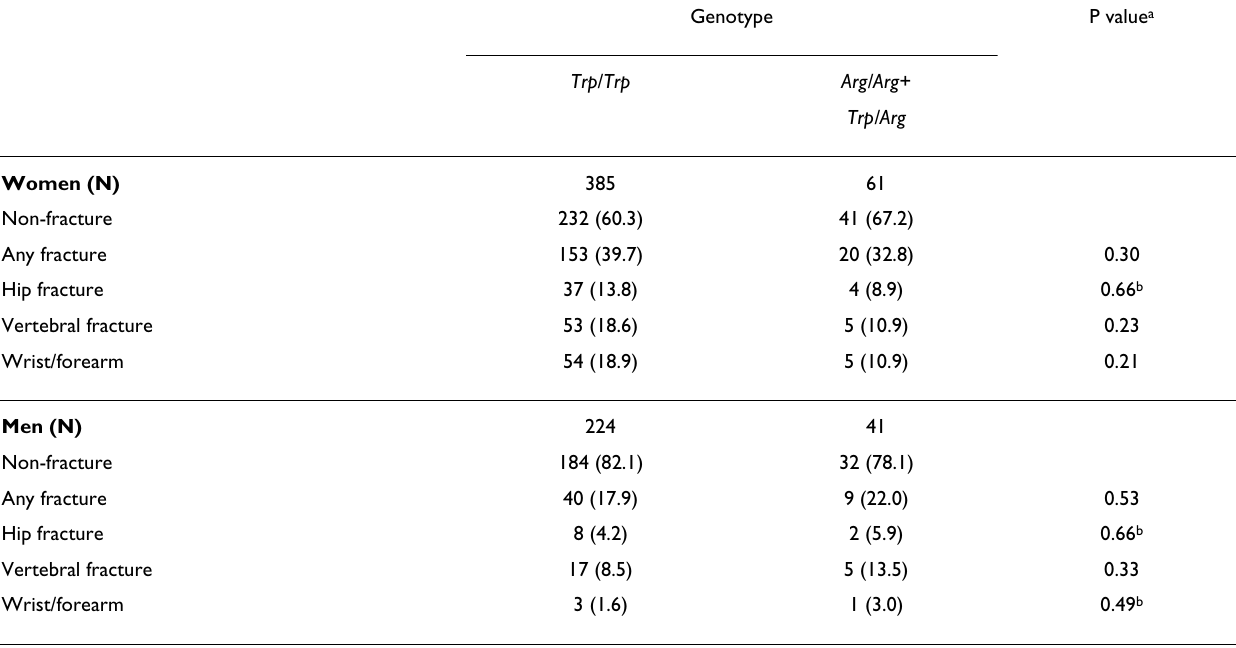
Table 4: Frequency of fracture types stratified by β 3-Adrenergic Receptor